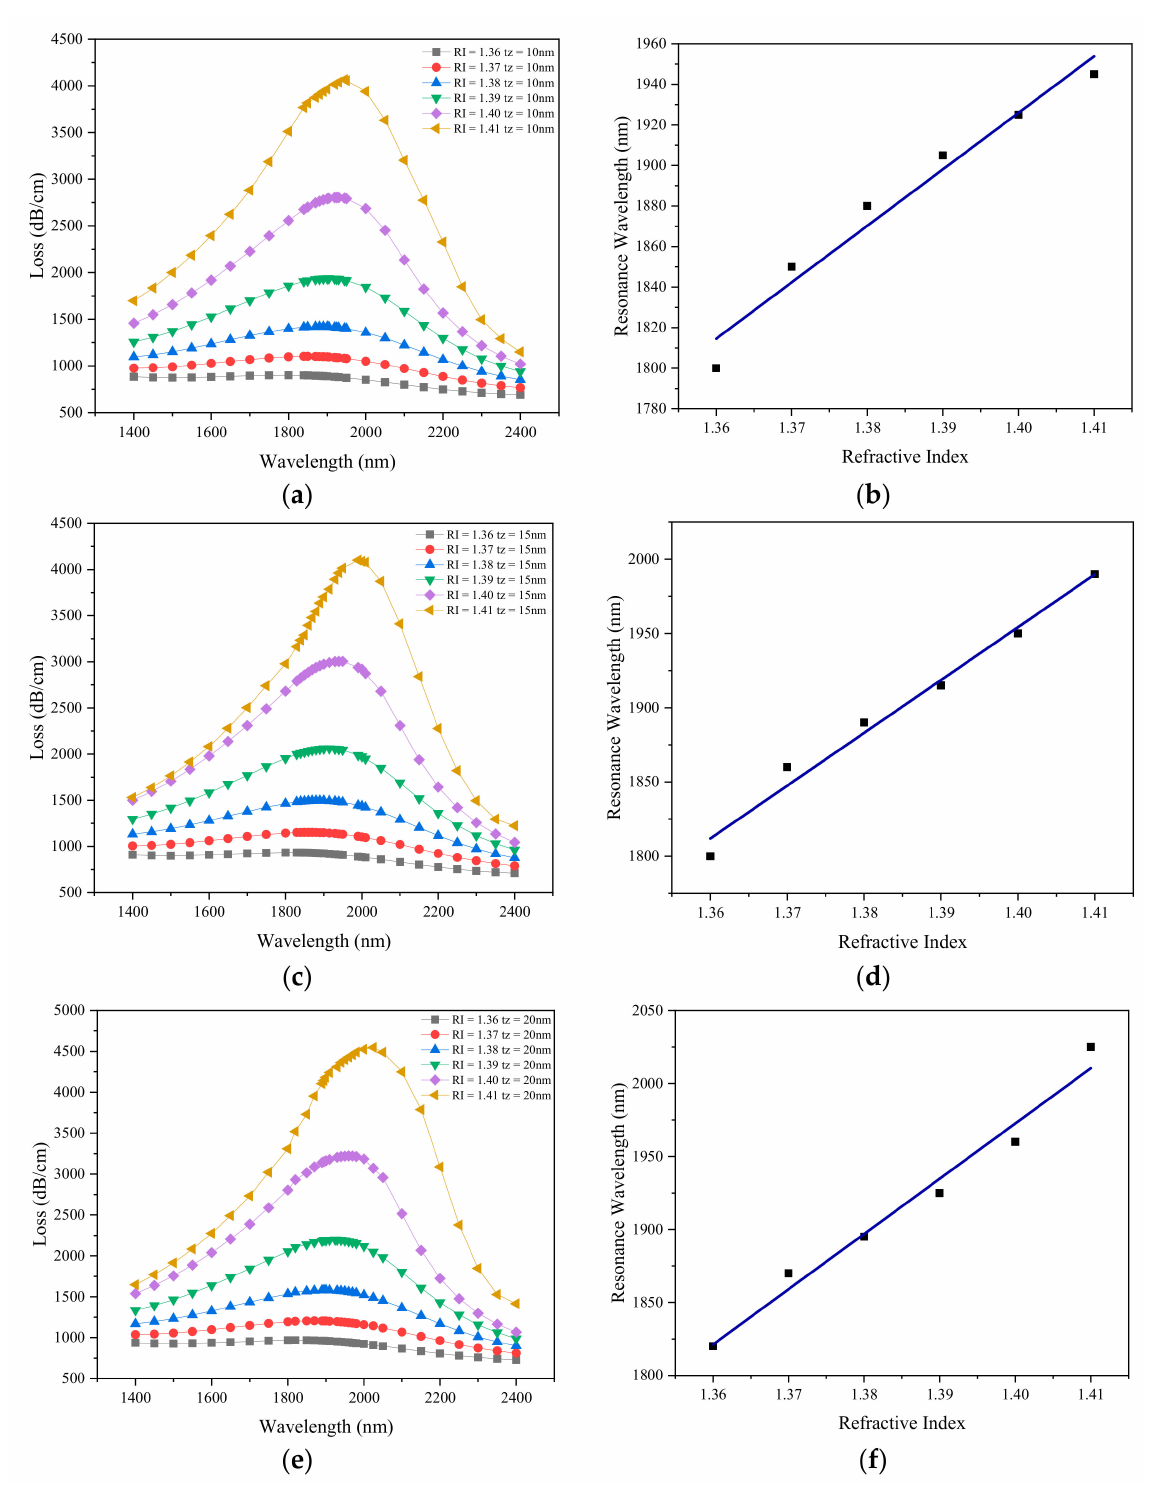
from Figure 6g, the fitting equation is y = 3785.7 x − 3327. When the thickness of ZnO is tz = 25 nm, as shown from Figure 6h, the fitting equation is y = 4485.7 x −